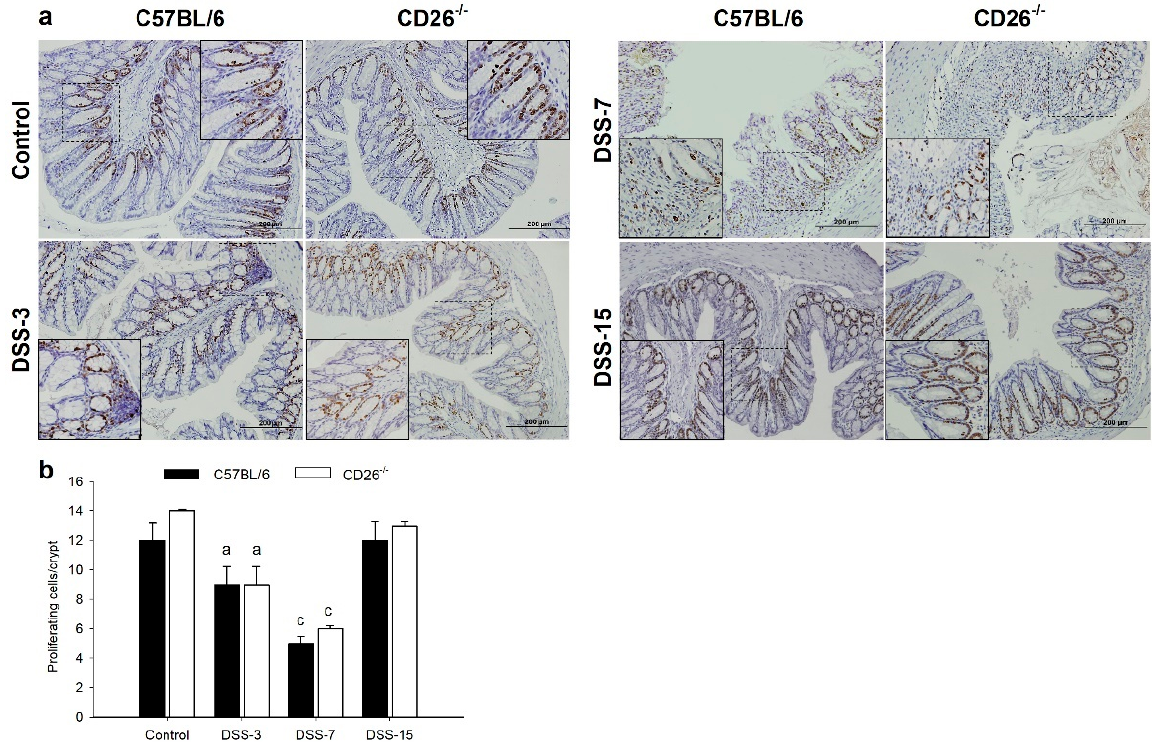
Figure 2. The influence of CD26 deficiency on the proliferative activity of the colonic cells during progression and resolution of dextran sulfate sodium (DSS)-induced colitis in C57BL/6 and CD26-deficient (CD26 − / − ) mice. ( a ) Representative images of immunohistochemical analysis of the expression of Ki-67 cell proliferation marker in colonic tissue of C57BL/6 and CD26 − / − mice treated with DSS. ( b ) Quantitative analysis of Ki-67 positive cells within the colonic crypts. Original magnification ×200. Insets represent digital zooms of the region defined by the dotted line. Scale bar: 200 μ m. Data are expressed as mean ± SD. n = 6 mice/each group. a and c denote p < 0.05 and p < 0.001 compared with the control group, respectively.